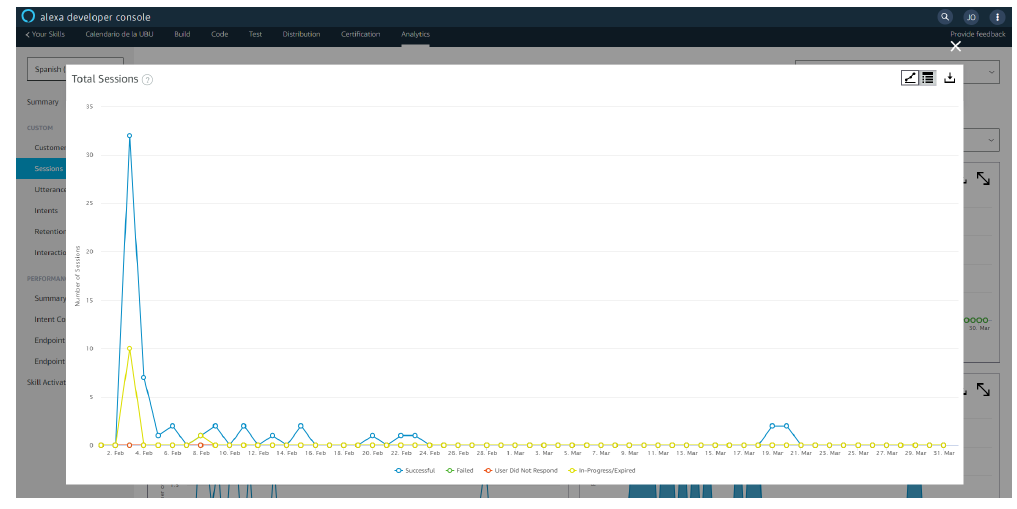
Figure 11. Total sessions opened towards the Alexa skill.